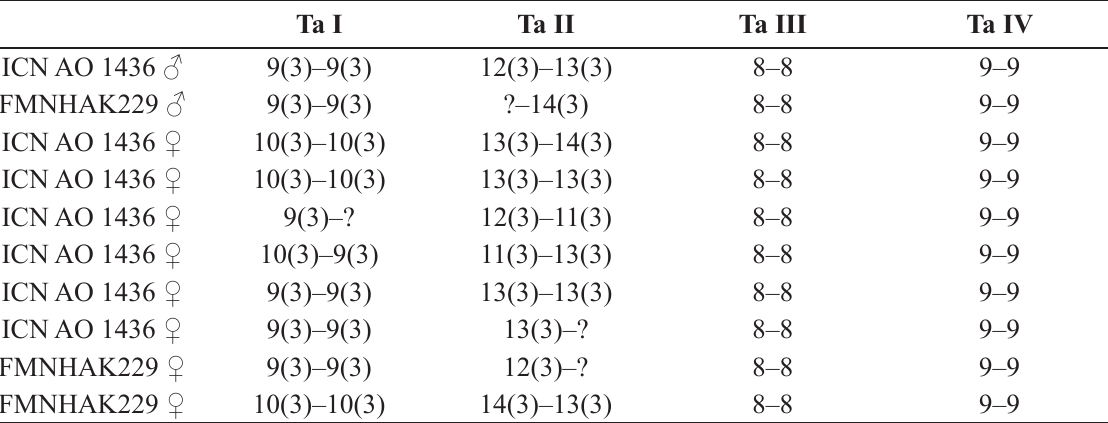
Table 8. Tarsal formula of Phalangodus kuryi sp. nov. (numbers in parentheses are the number of